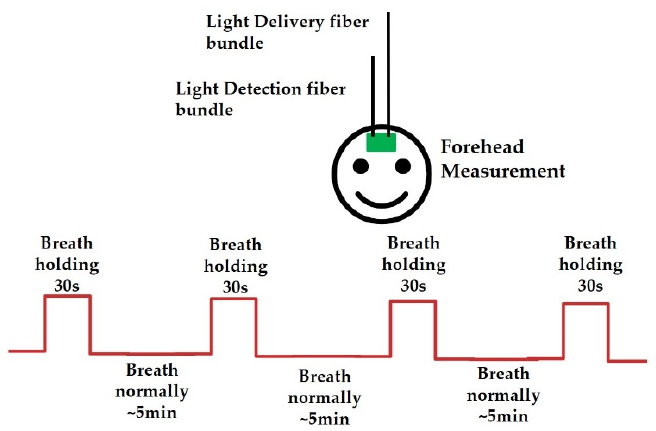
Figure 9. Set-up and protocol for the breath-holding test using the SCISCCO system.